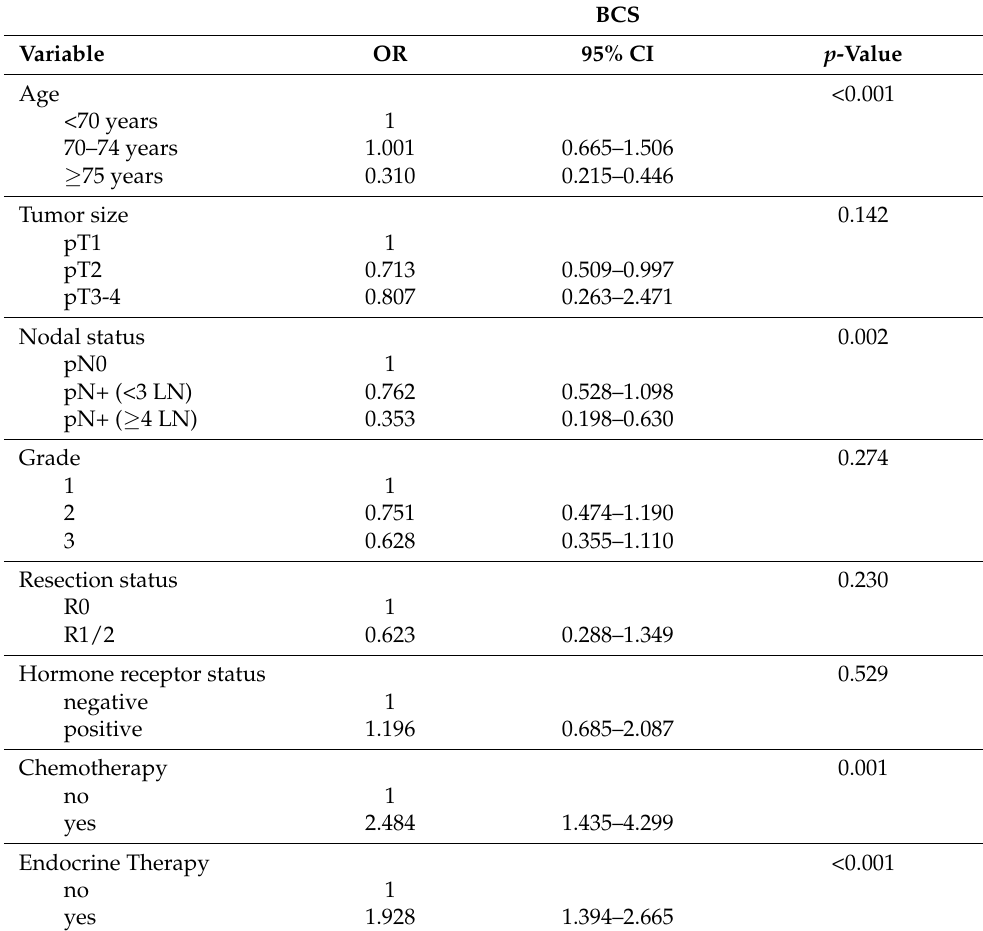
Table 5. Adjusted Odd Ratios (OR) and 95% Confidence Intervals (CI) from the multiple logistic regression analysis for the administration of postoperative